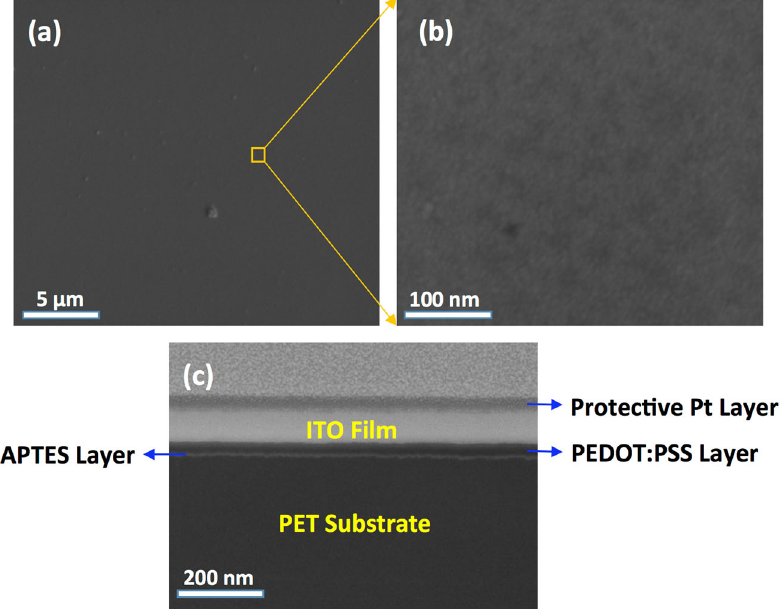
Fig. 3 SEM images of ITO coated on PEDOT:PSS on PET substrate, top surface image with ( a ) low resolution and ( b ) high resolution images, and ( c ) high resolution cross-sectional image of IPP stacked layer (scale and involved layers are shown in respective fi Fig. 2b. Results show that the average transmittance values are, as-